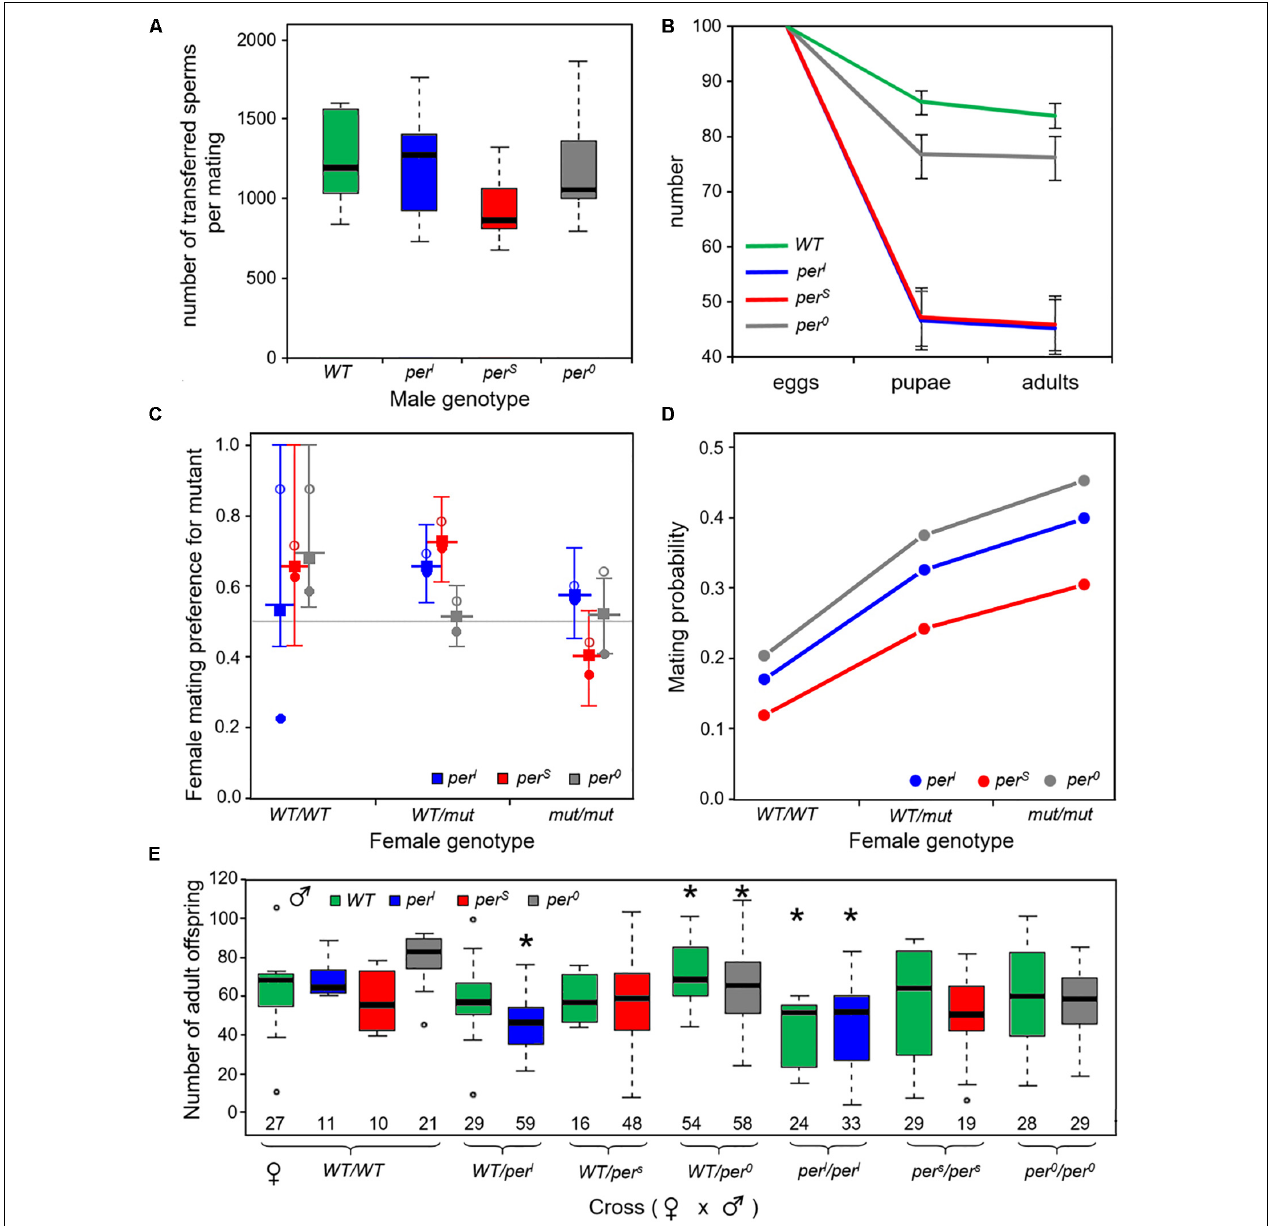
FIGURE 10 | Number of transferred sperms, flies developing from 100 eggs, mating preferences of female flies and offspring of a female fly (A) . Mean number of transferred sperm lies between around 950 and 1250 sperms ( n = 7 or 8 per genotype) and was not significantly different between the different fly strains (B) . Number of developing pupae and adults from 100 eggs of homozygous wildtype and period mutant flies, respectively, showing that the mutants had significant lower developmental survival rates than the wildtype flies. Error bars provide binomial 95% confidence intervals. Separate statistical analysis and significance testing was carried out from egg to pupae and then from pupae to adults (details see text) (C) . Estimated female mating preferences (probability to favor a mutant male over a wildtype male). The different genotypes are color coded. Open circles reflect choice in experiments where wildtype males were marked, dots in experiments were the mutant male was marked (see section“Materials and Methods”). The square shows the preference for mutant males estimated from the empirical data according to Eqs 1–5 from the main text. The longer horizontal line provides the median value and the error bars span the 95% confidence limits based on the Monte-Carlo simulations (100,000 replicates; see section “Materials and Methods”). Heterozygous WT/per l and WT/per s females preferred the mutant male, respectively. Similarly, wildtype females had a slight preference for per s and per 0 males (for details see text) (D) . Overall probability of successful mating in the mating preference tests dependent of female genotype [color code as in (C) ]. Logistic regression indicates a significant effect of both, the female’s genotype and the mutant male under investigation. Mutant females had a higher probability to mate than wildtype females and per 0 and per l males were more successful in mating than per s males (for details, see text) (E) . Number of adult offspring from the mated females shown in (C) . The data showed a large variability, but nevertheless revealed that per l females had a lower and WT/per 0 a higher number of offspring (asterisks). Details see text. The number of females contributing to this analysis is indicated at the bottom of each box